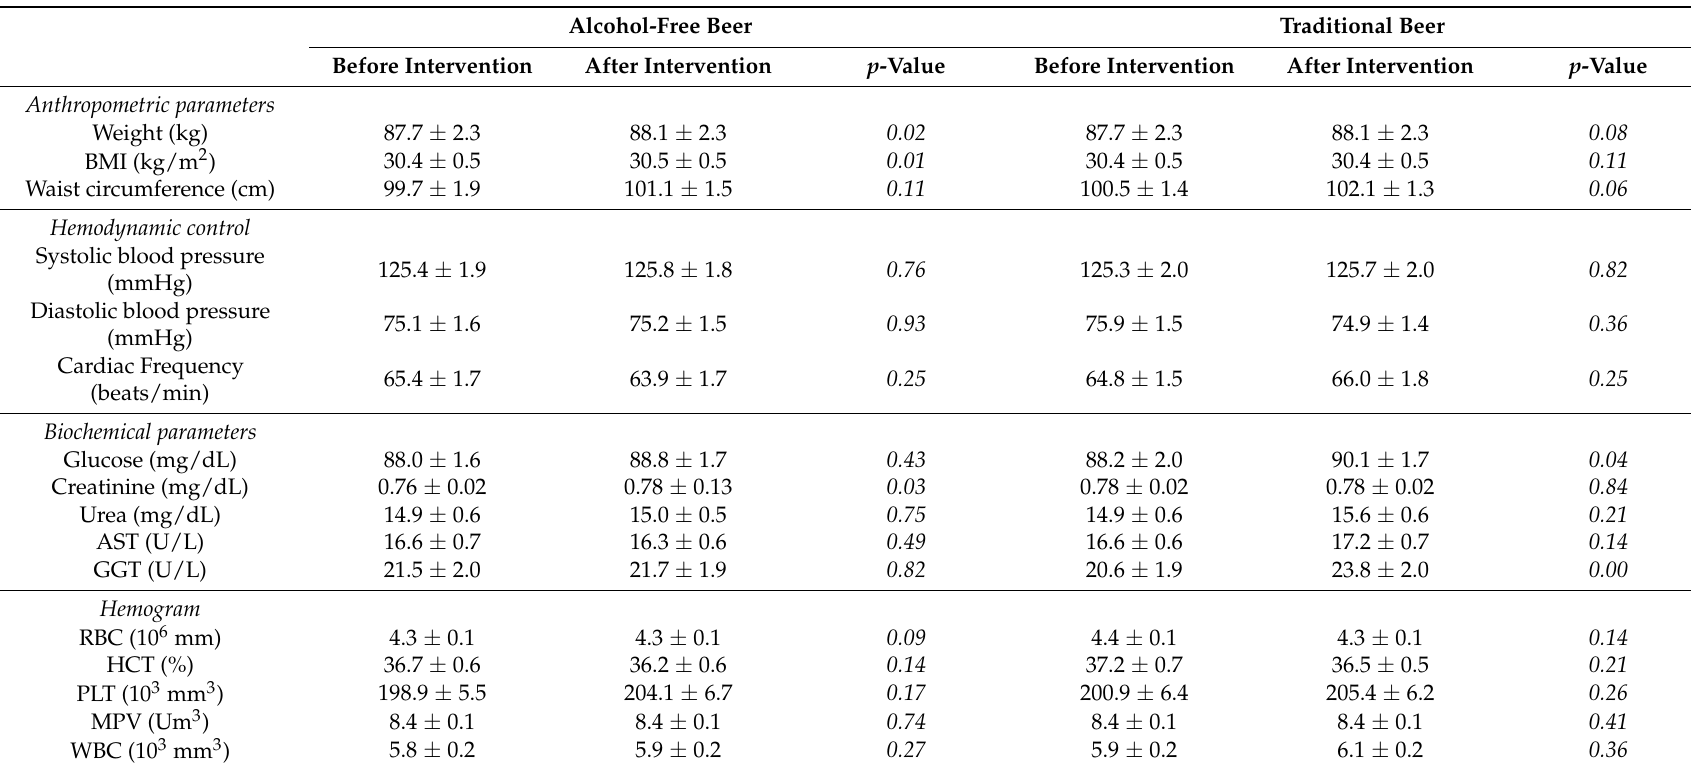
Table 2. Anthropometric and hemodynamic variables, biochemical parameter and hemogram profile before and after four-week dietary intervention with alcohol-free and traditional and